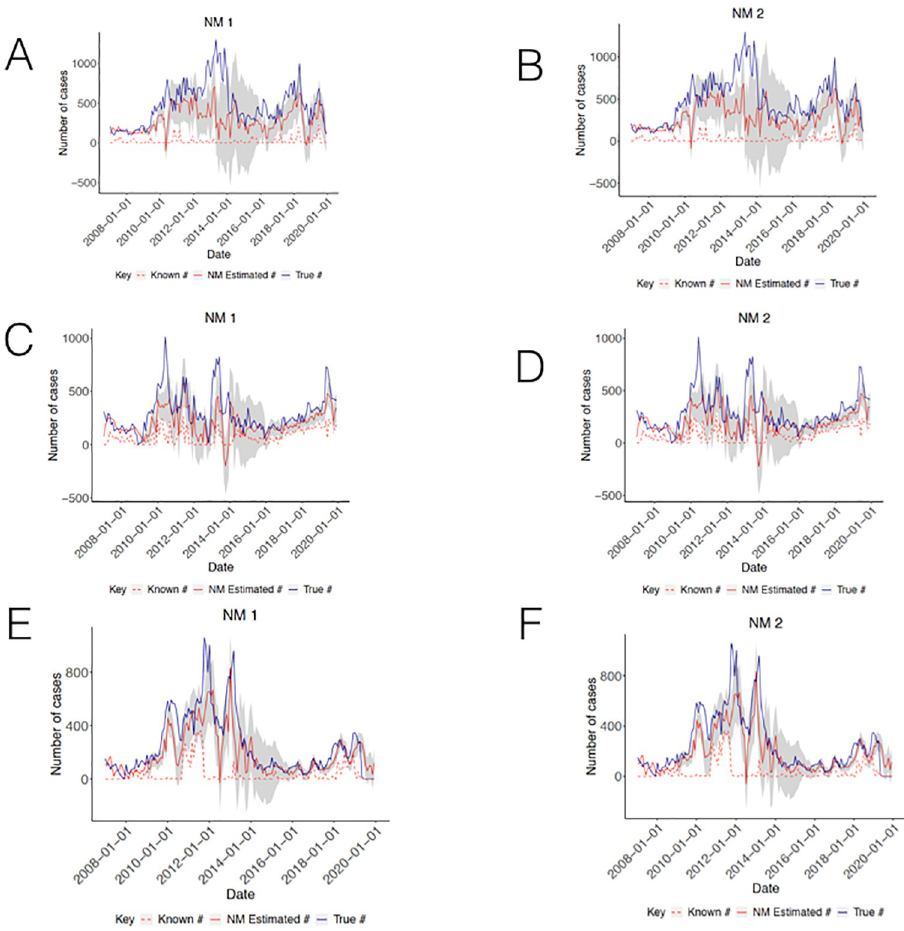
Fig 4. Results from Network models. (A) Region 1 NM1 (B) Region 1 NM2 (C) Region 7 NM1 (D) Region 7 NM2 (E) Region 8 NM1 (F) Region 8